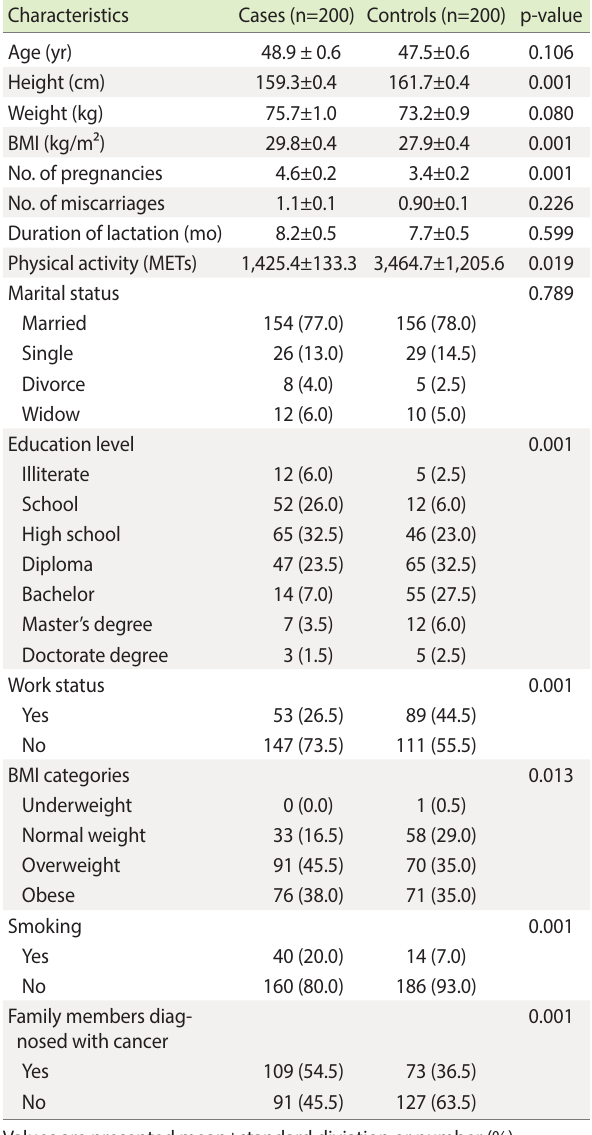
Table 1. Characteristics of the study participants